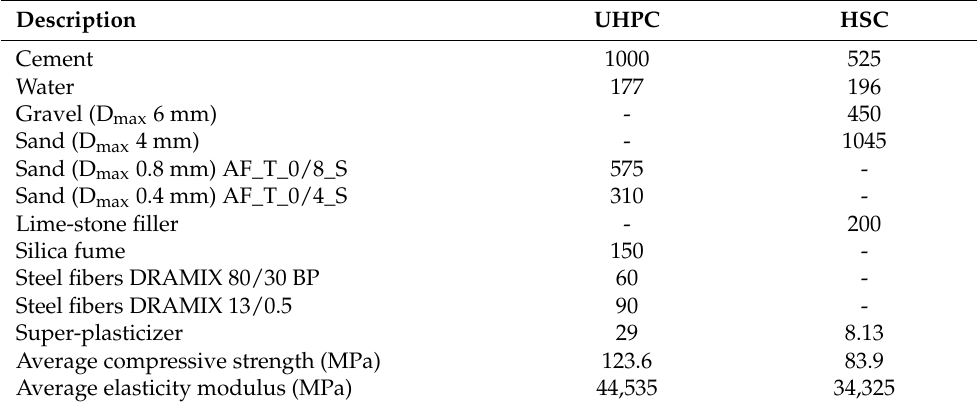
Table 2. Mixture proportions (kg/m 3 ).